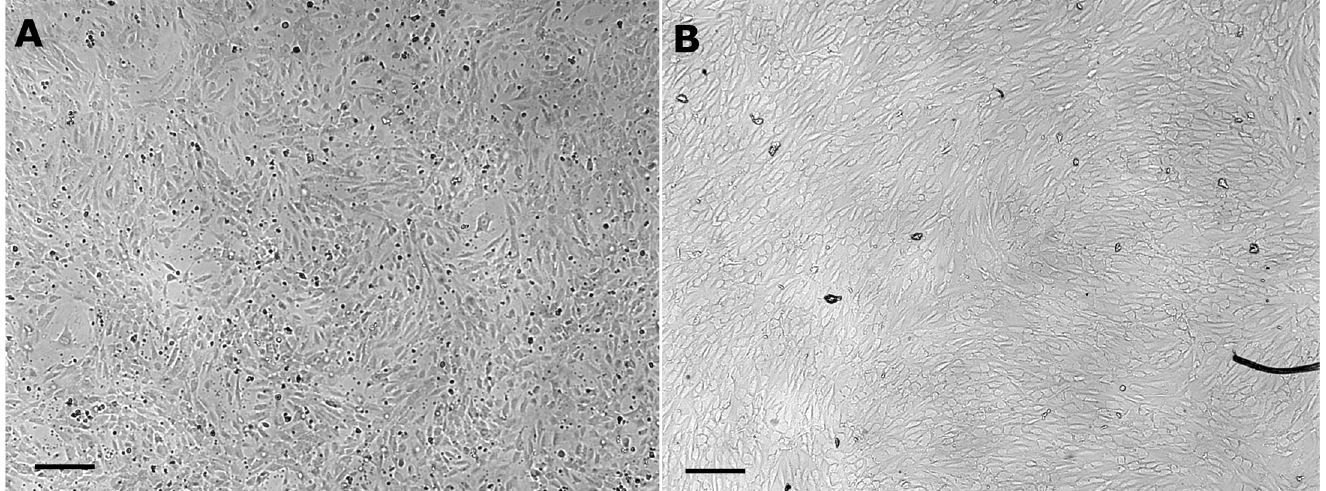
Fig 3. Comparative light-microscopic picture of HUVECs cultured on Lumox ™ slides for 7 days. A – Static control. B — Shear stress stimulated cells. Scale bar = 200 μ m.